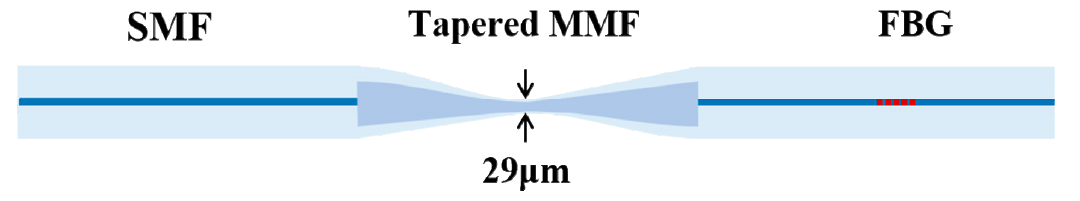
Figure 1. Schematic diagram of the sensor structure.